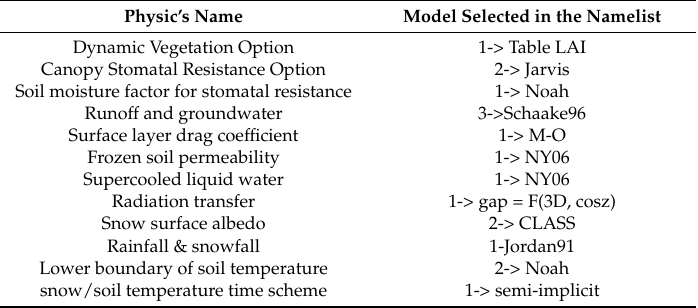
Table 1. Namelist of physics options